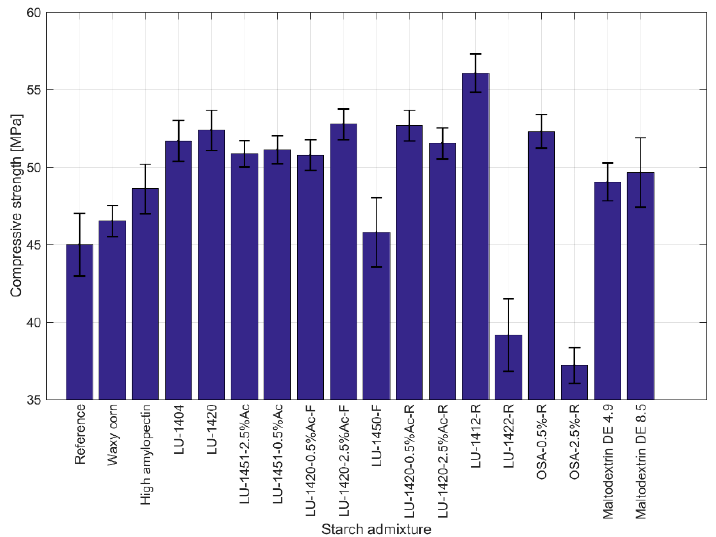
Figure 6. Compressive strengths of cement-mortar beams, depending on the type of admixture used.